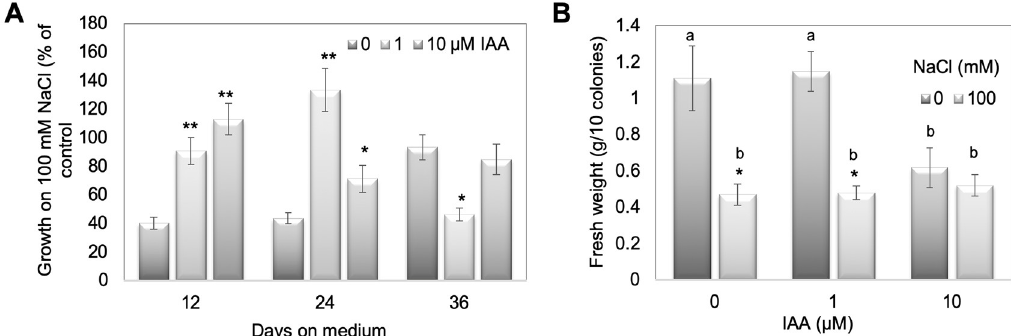
Figure 6. IAA (1 and 10 µ M) treatment of WT together with high salt concentration (100 mM). ( A ) Growth rate as percent of control between 0 and 36 days given as diameter of three time intervals at which the measurements were done and ( B ) fresh weight after 36 days was recorded. In ( A , B ), the mean values for 12 plates with 10 colonies on each plate are given. Asterisks in ( A ) denote statistically significant differences between control and IAA treatments on 100 mM NaCl expressed as percentage of the control, in ( B ) denote statistically significant differences between control and NaCl treatment (* p < 0.05, ** p < 0.01), and different letters in ( B ) indicate differences between control and IAA treatments. Calculations for growth rate in ( A ) were done by measuring the diameter of colonies at 0 days (day of transplanting on fresh medium), diameter of colonies at 12, 24, and 36 days on treatment medium and subtracting the respective later time point from the earlier one. The value for 12 days is thus the difference/growth rate between day 0 and day 12, the value for 24 days growth between 12 and 24 days, and the value for 36 days represents the growth between 24 and 36 days. To show the effect of NaCl compared to control, for each value +/− IAA the percentage of growth on 100 mM NaCl compared to the control was calculated. Values higher than the control value without IAA are an indication that the moss plants are performing better on simultaneous NaCl and IAA treatments.